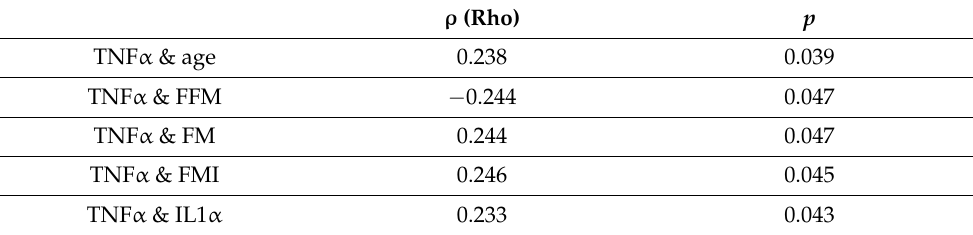
Table 5. Association of TNF α levels, age, body composition and biochemical markers; n =